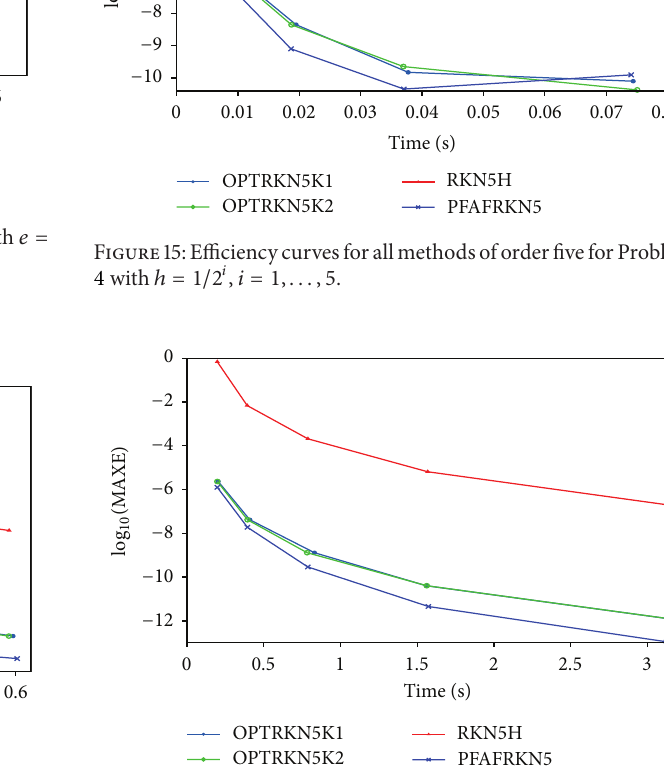
Figure 16: Efficiency curves for all methods of order five for Problem 5 with ℎ = 1/2 𝑖 , 𝑖 = 5, ...,9